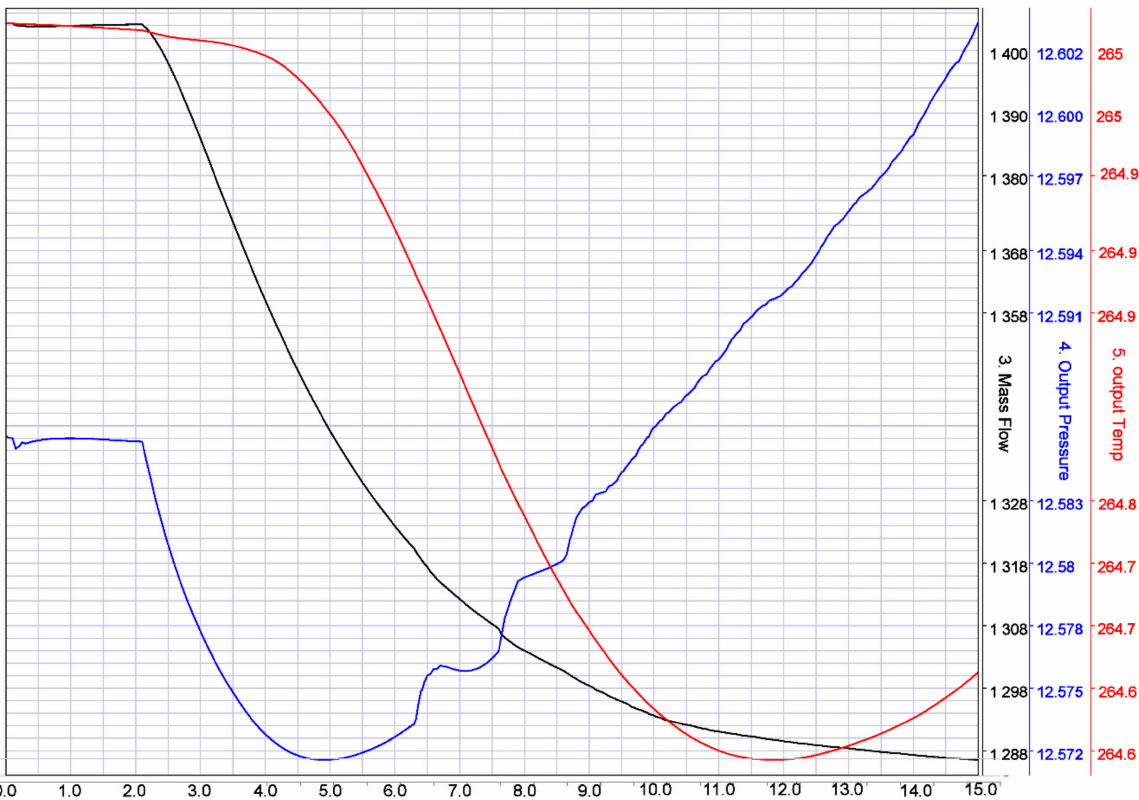
Figure 9. The mass flow, output pressure, and temperature of the related pump in Apros when a fault occurs in the electrical